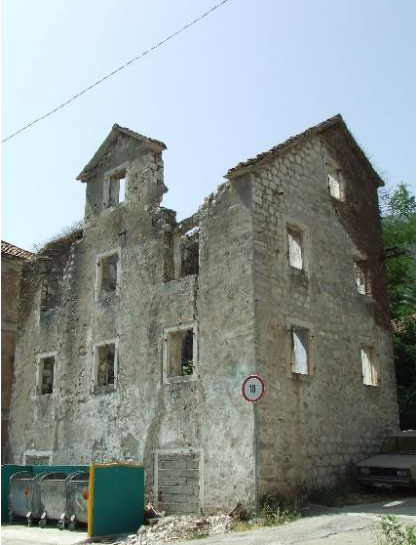
Figure 8. Cracking of belvedere structure in Prčanj and Stoliv.